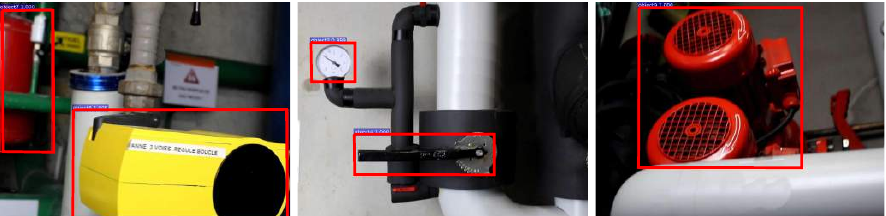
Figure 11. Object detection results (shown in red rectangles) using the fine-tuned Faster R-CNN